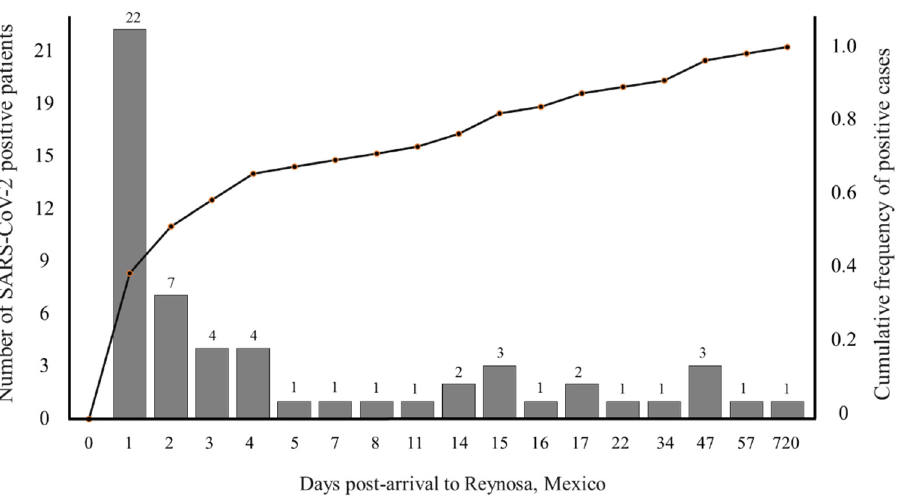
Figure 1. Cumulative frequency of the number of individual migrants arriving to “The Migrant House” in Reynosa, Mexico, that tested positive SARS-CoV-2 antigen at different days post-arrival. Integrated health services supported by the network of TMH, MSF, and NGOs are paramount to improving access to rapid free tests in vulnerable populations [25], because testing for virus infection is critical to detecting COVID-19 cases for quarantine and con- tact tracing, as well as for providing medical care. Undoubtedly, migrants are a high-risk population for virus infection; it has been reported that migrants are disproportionately represented among COVID-19 cases and deaths. Risk factors for migrants include high- risk occupations, overcrowding, and barriers to healthcare, including imprecise infor- mation, languages, and limited human rights [26]. For example, in Saudi Arabia and Sin- gapore, low-skilled migrant workers in crowded dormitories showed that 75 and 95%, respectively, of all newly confirmed cases were among migrants, and 93% of total cases were associated with migrants’ dormitories in Singapore [27]. Although migrants depend heavily upon services of lodging, food, and medical care provided by the charitable net- work of TMH, MSF, and NGOs in Reynosa, this network lacks sufficient resources to pro- vide all the needed services. The current scenario for migrants in northern border cities is worrisome, as expulsions from the US are ongoing. In addition, migrants seeking asylum in the US travel from Tapachula, a southern Mexico border city, to US–Mexico border cities. Here, the needs of migrants overwhelm the capacity of local health authorities and NGOs [28]. The emergence of new SARS-CoV-2 variants of concern will likely continue to result in epidemic waves. Thus, there is an urgent need to enhance medical care for this migrant population. Further studies are needed to confirm the role of migratory popula- tions relative to resident populations in the spread of SARS-CoV-2 and similar emerging infectious diseases. A limitation of the current study is that we were unable to confirm exactly when and where prior exposure to SARS-CoV-2 occurred for the migrants arriving to TMH in Rey- nosa. While we report variation among populations of migrants coming from different countries of origin, this prevalence does not necessarily reflect infection from the country of origin, and instead could reflect variation in the risk of exposure to SARS-CoV-2 during transport or staging in different locations along the route to the US. 4. Conclusions Here, we tested 370 migrants from ten countries arriving at the US–Mexico border, and 56 tested positive for the SARS-CoV-2 antigen, which triggered a quarantine protocol